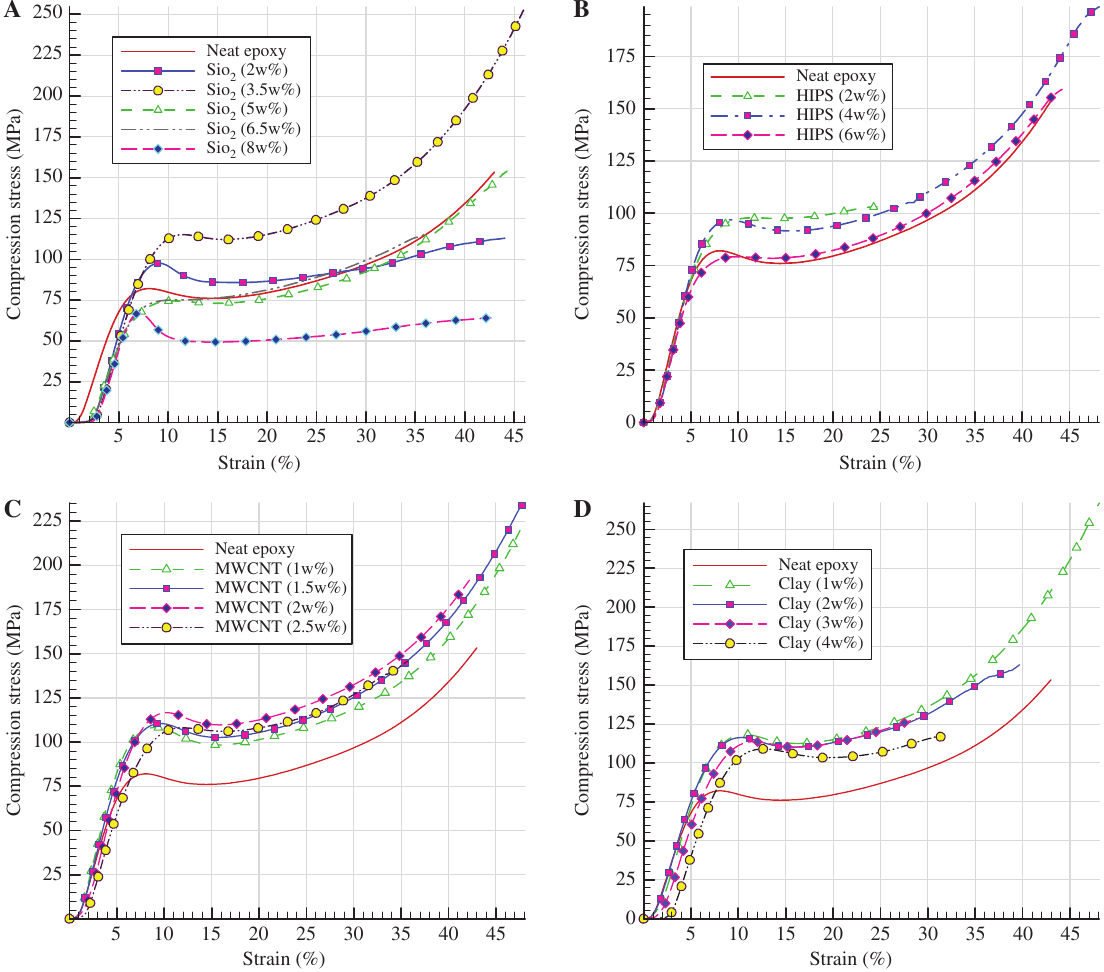
, (B) epoxy/HIPS, (C) epoxy/MWCNT and 2